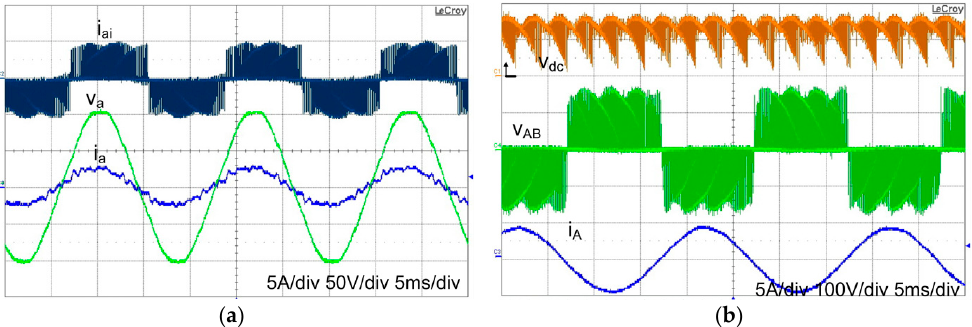
Figure 13. ( a ) Input waveforms; and ( b ) DC-link voltage and output waveforms with the conventional method at m = 0.6 and f out = 50 Hz ( PF = 0.94).